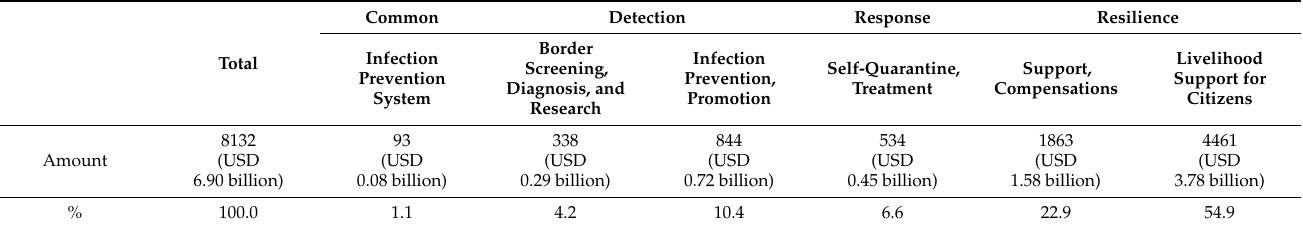
Table 1. COVID-19 response budget by category in 2020.